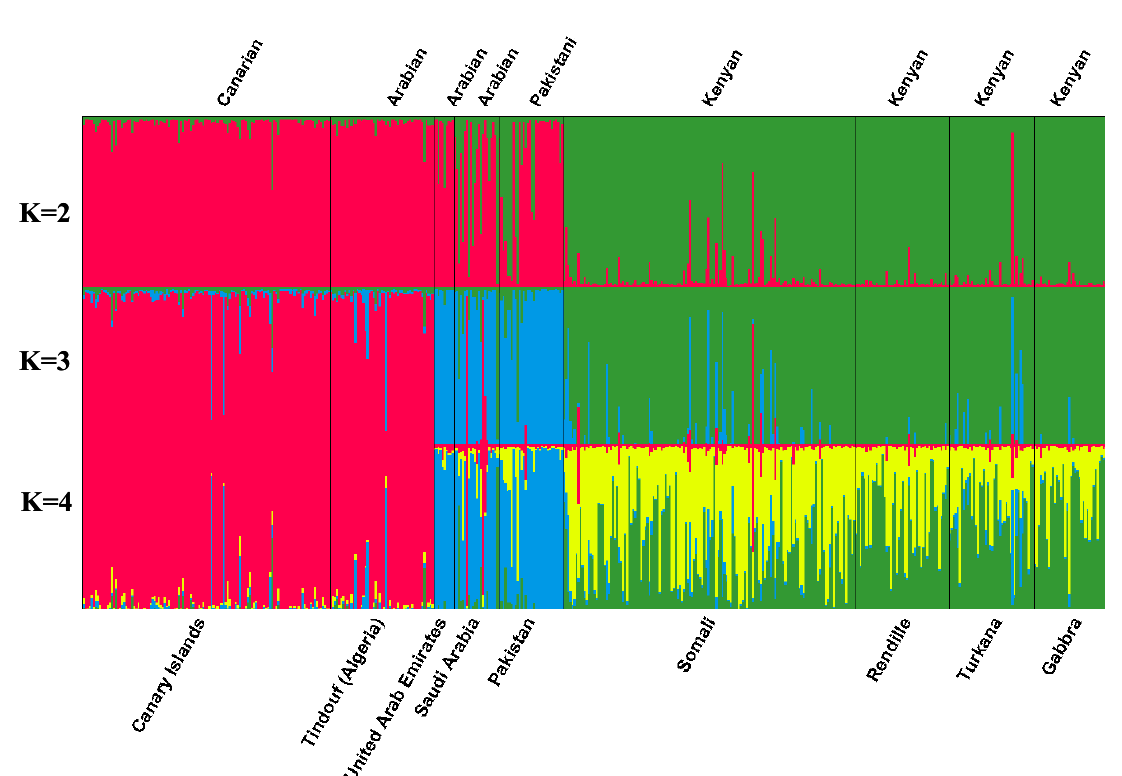
Figure 2. Stacked vertical line plots of the estimated membership fractions of each individual analyzed for each of the k inferred clusters with k from 2 to 4. Individuals are grouped by